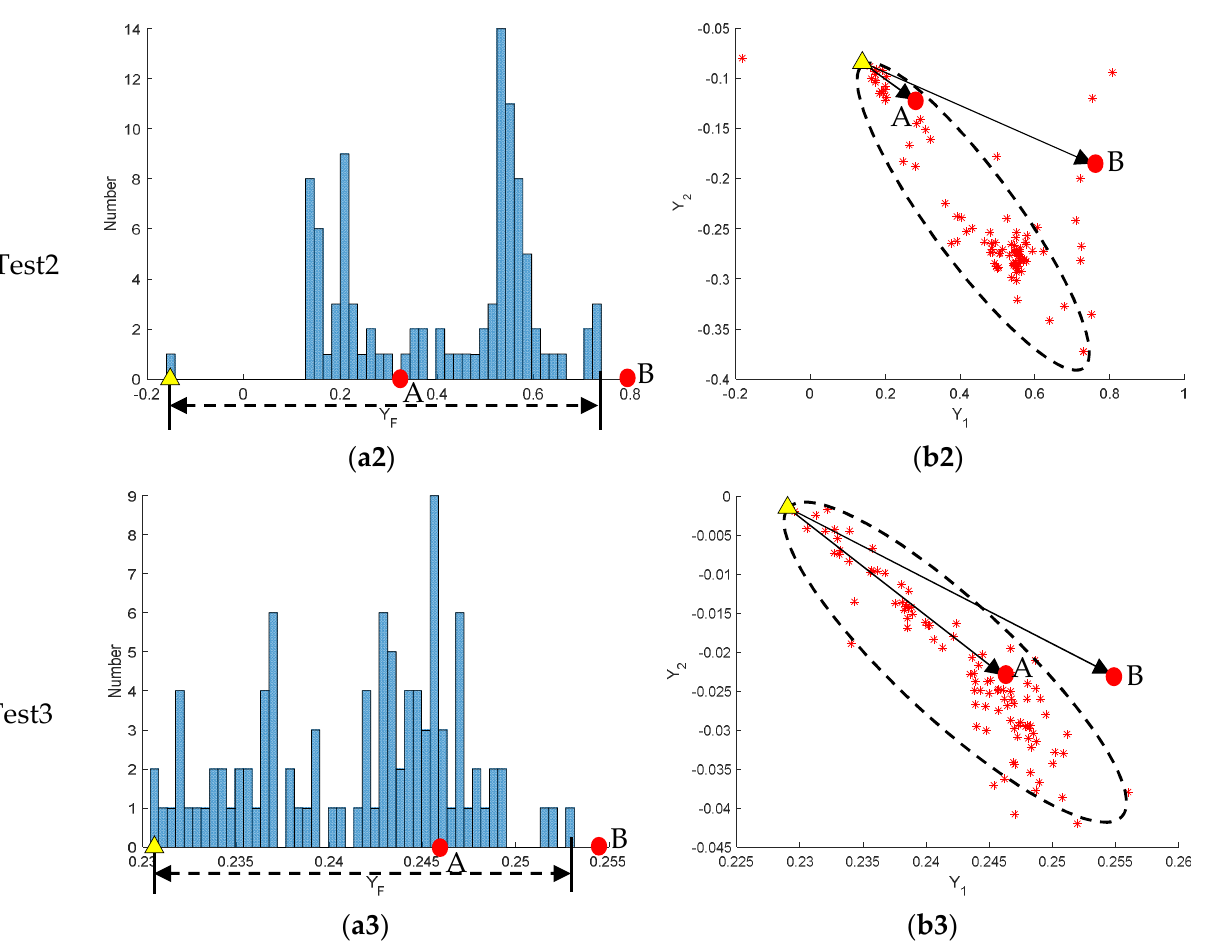
Figure 9. Statistical results. ( a1 , a2 , a3 ) and ( b1 , b2 , b3 ) are three groups of statistical histograms of Y F and scatter plots of Y , which are calculated and counted from corresponding points removing false points in Figure 4(c1,c2,c3), respectively. In addition, the yellow triangles are the lower-bound points of the reasonable boundaries of Y F and Y , respectively, and the red dots A and B are two Y F or Y values corresponding to two different FMs.